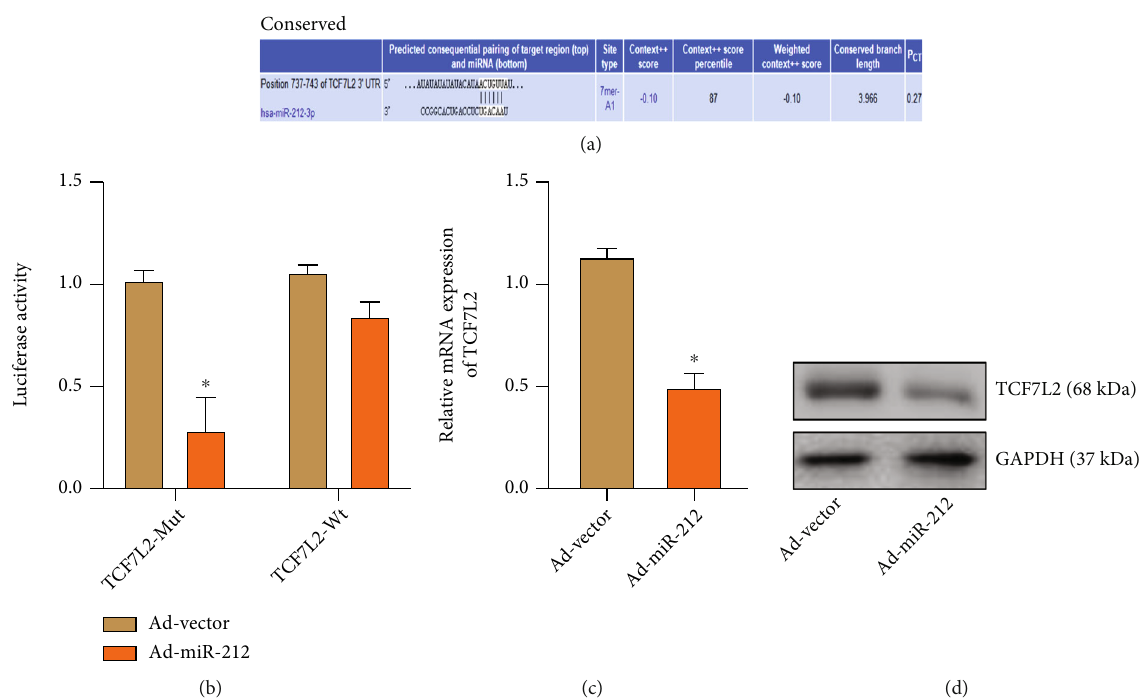
Figure 4: miR-212 regulates CH by targeting TCF7L2. (a) Results of site prediction. (b) Double-luciferase reporter gene assay ( “ ∗ ” indicates statistical di ff erence from the Ad-vector+TCF7L2-WT group P < 0 : 05 ). (c) The expression of miR-212 in the Ad-vector and Ad-miR-212 groups ( “ ∗ ” indicates statistical di ff erence from the Ad-vector group P < 0 : 05 ). (d) The band of TCF7L2 in the Ad-vector and Ad-miR- 212